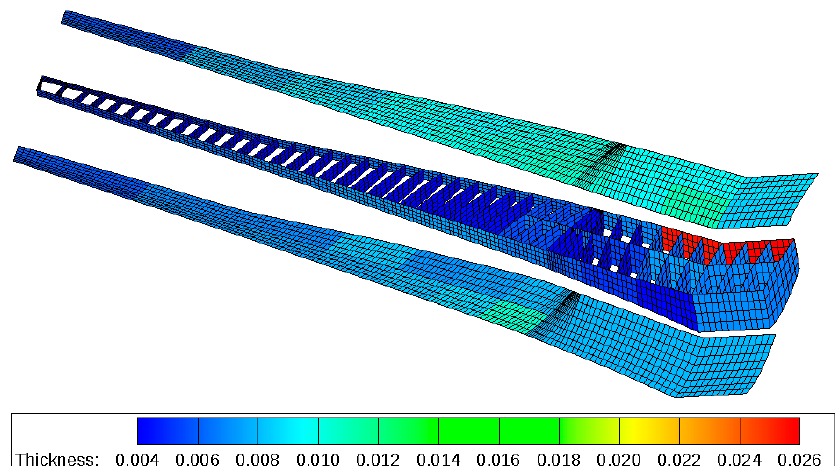
Figure 32. Sizing load cases for each design field—enhanced MLA + GLA.